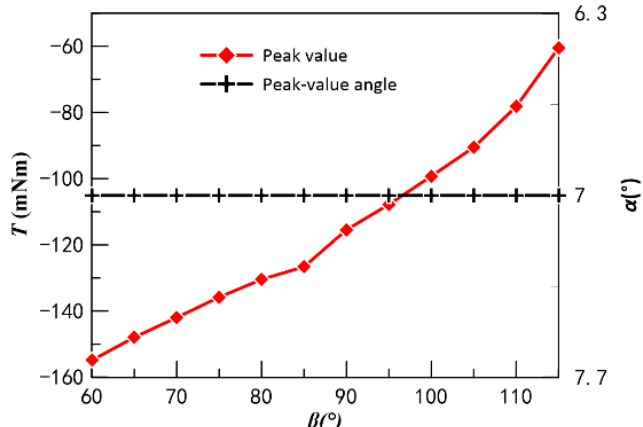
Figure 11. Curve of β versus peak cogging torque.